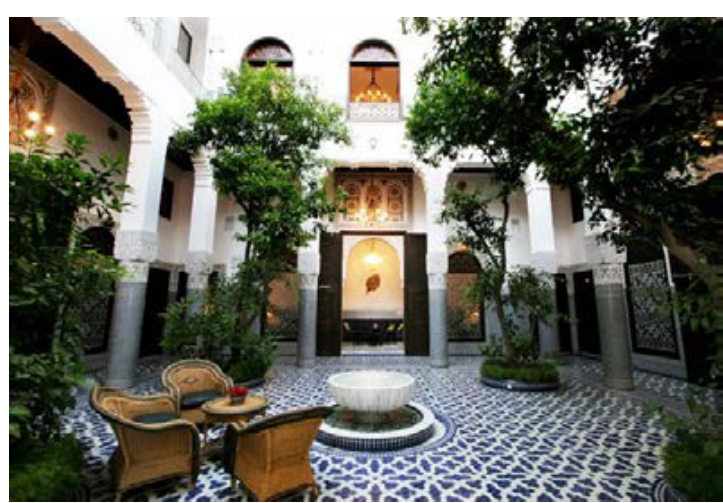
Figure 14. Riad Misbah, Fez (Steele &Fathy,